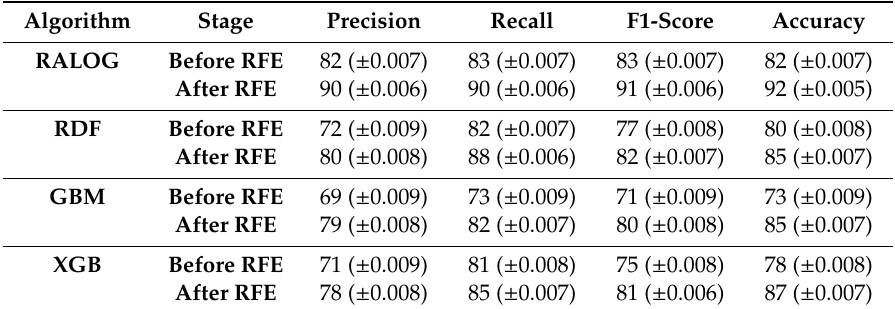
Table 6. Percentage average precision, recall, F1-score, and accuracy with confidence intervals of learning algorithms at each experimental stage of feature scaling with the RF-RFE